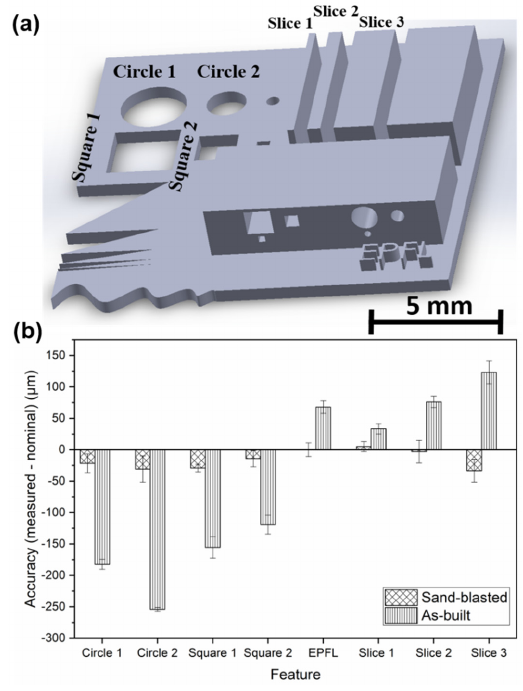
Figure 25. ( a ) CAD of a benchmark with complex features, whose printed version is shown in Figure 14b, and ( b ) accuracy of some of the features in the as-built and sandblasted conditions. Modified from [32], with permission from Elsevier, 2021.